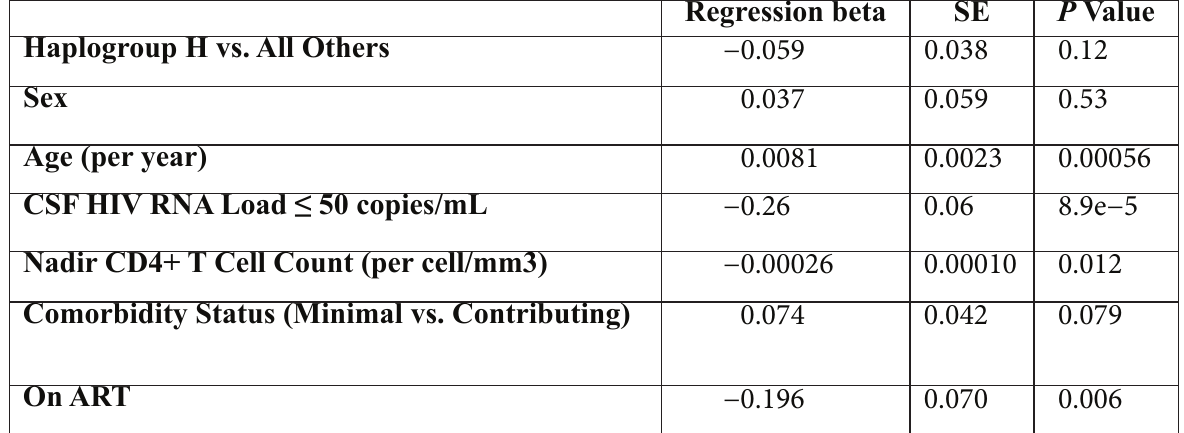
Supplemental Table 6. Multivariate linear regression results for log CSF TNF-α with mitochon - drial haplogroup H for all Caucasian participants (N =